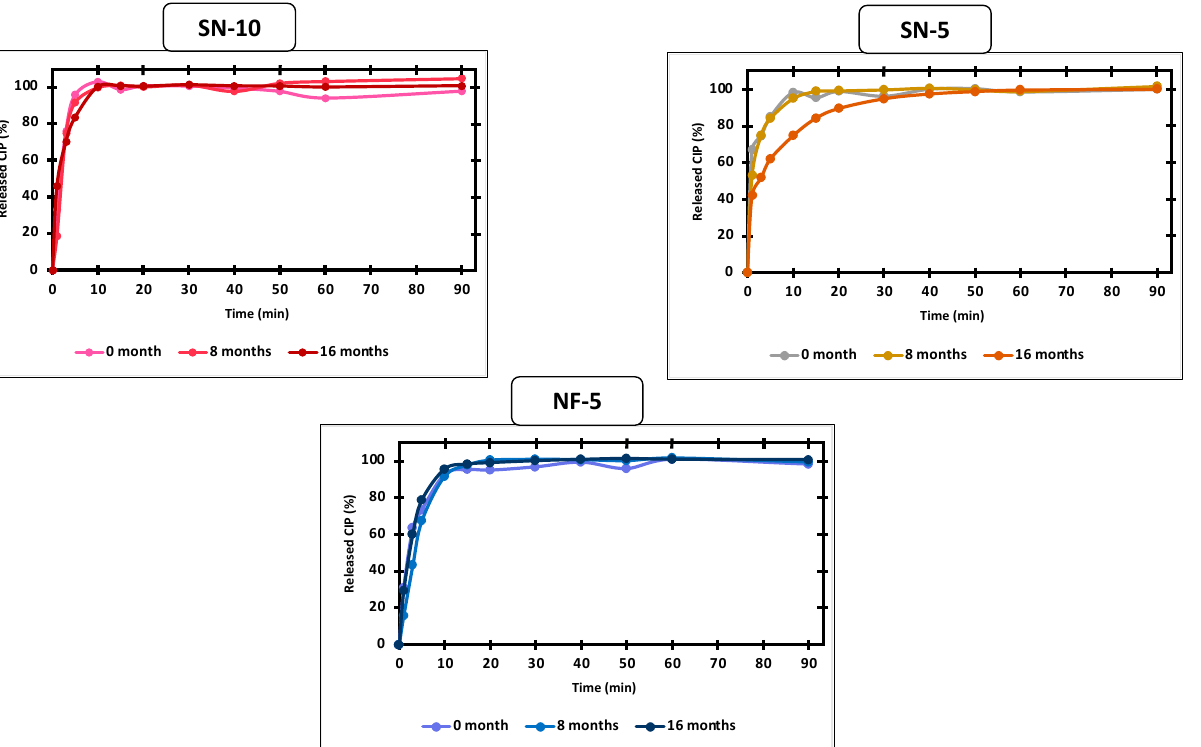
Figure 10. Comparison of in vitro ciprofloxacin (CIP) release of nanofibers produced using single- nozzle (SN-10 and SN-5) and nozzle-free (NF-5) electrospinning after 0, 8, and 16 months of storage. After 8 months of storage, there was no change in the drug release of any samples, but at the age of 16 months, the SN-5 sample showed an approximately three-fold slower release rate.